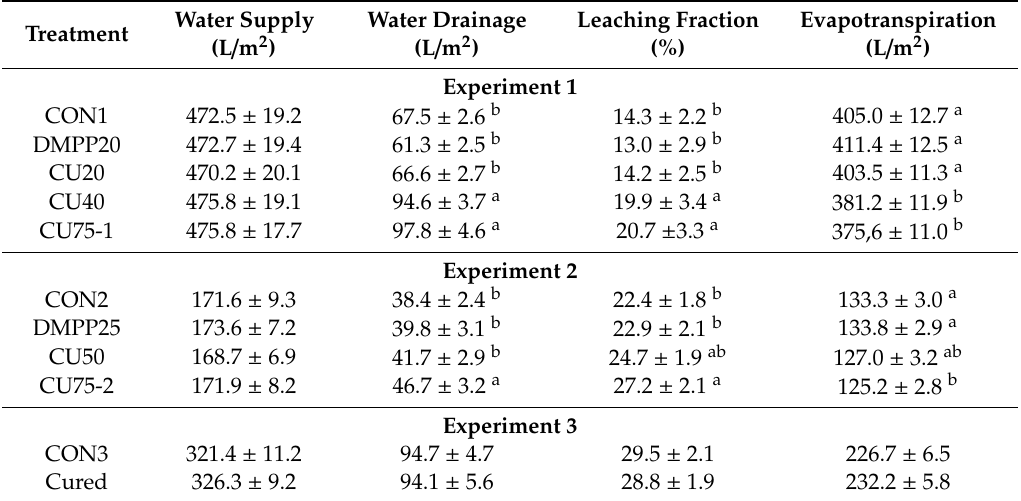
Table 4. E ff ect of di ff erent fertilization strategies on the water balance.